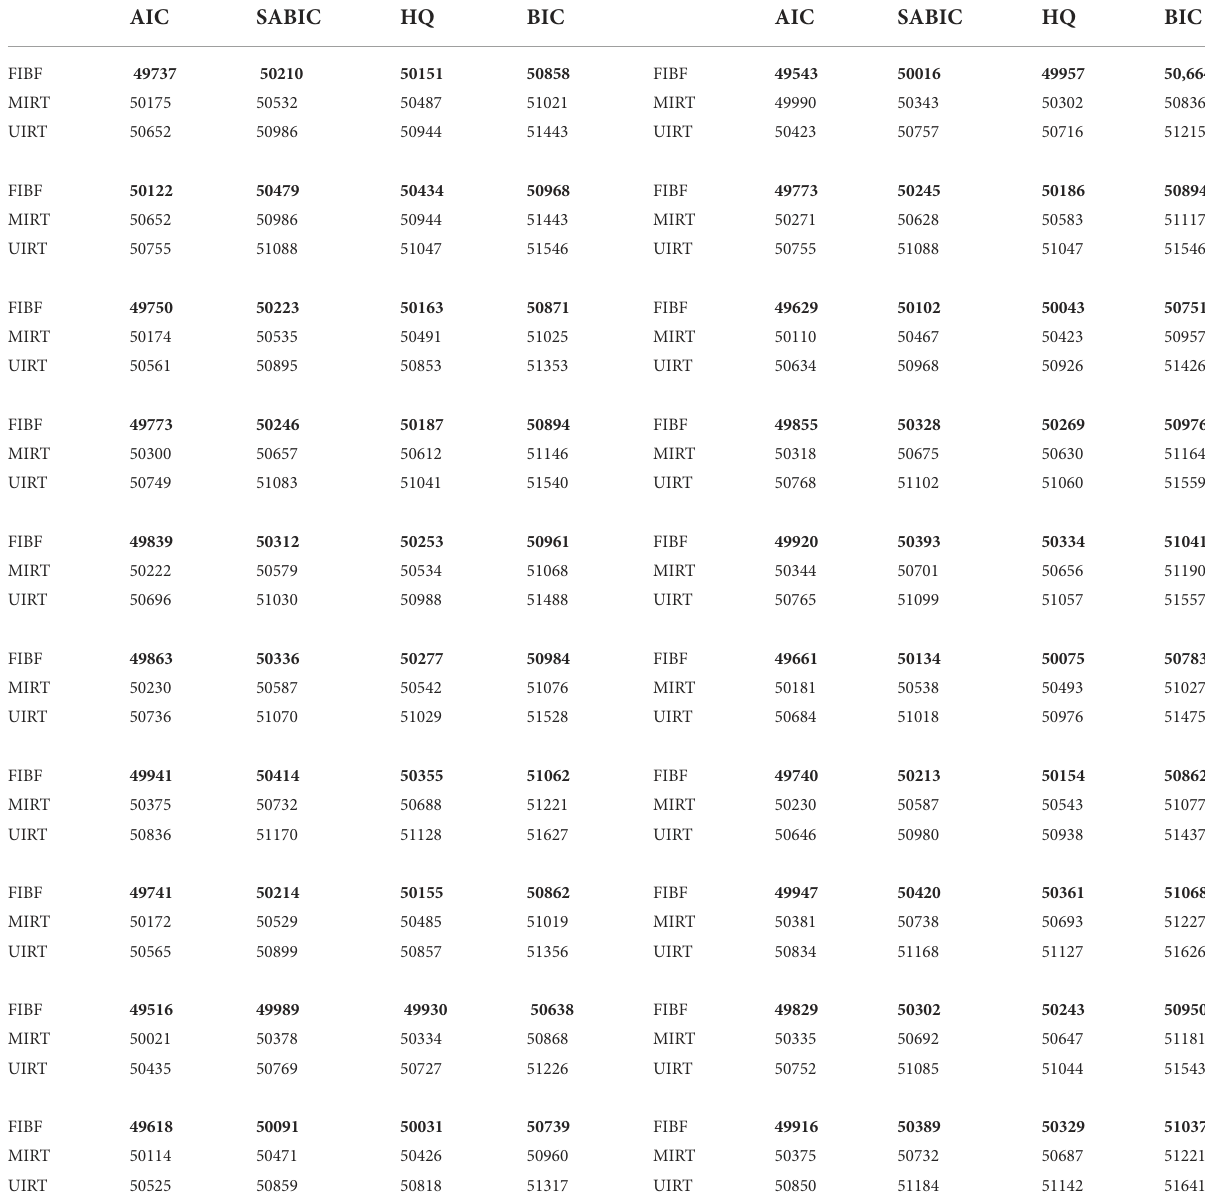
TABLE 2 Four model selection indices (AIC, SABIC, HQ, and BIC) of the three competing models (FIBF, MIRT, and UIRT) under the condition that the generating model is